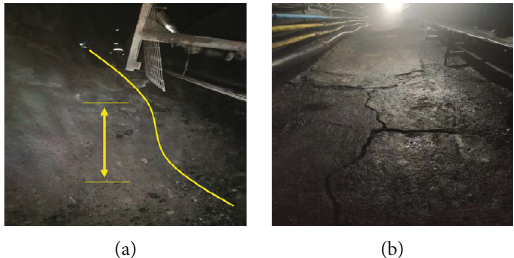
Figure 6: The damage of fl oor: (a) fl oor heave. (b) Stress cracking of fl